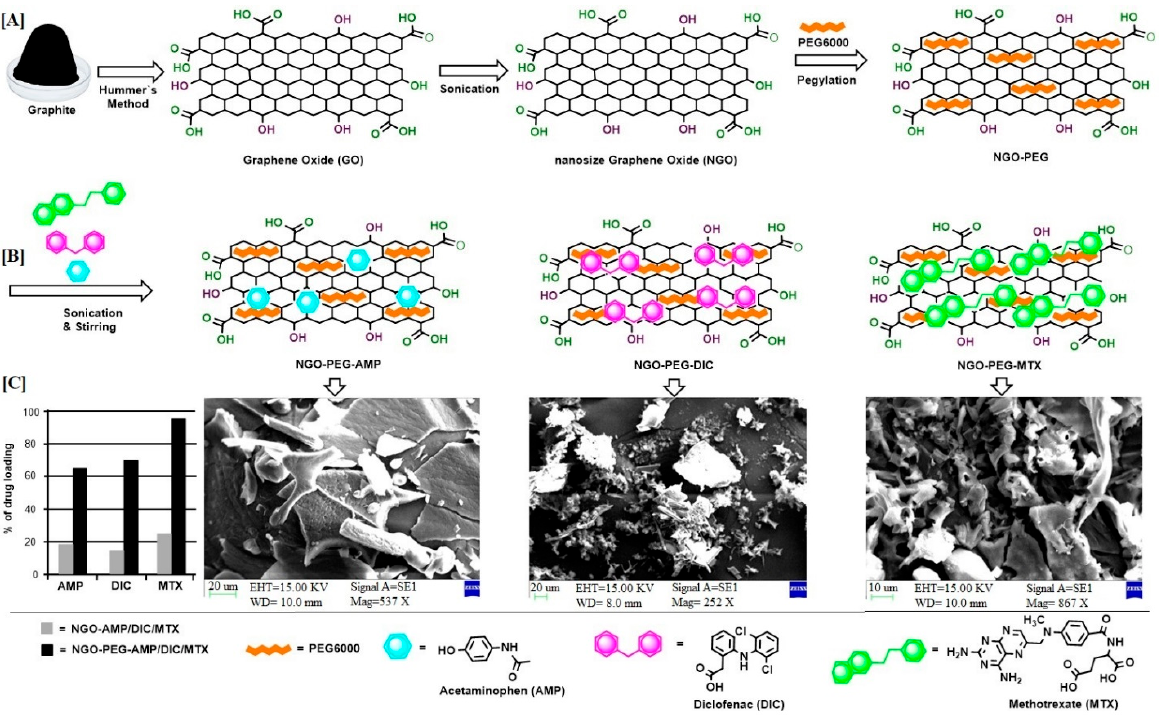
Figure 3. Schematic illustration showing the impact of the molecular structure of the drugs on the drug loading efficiency of NGO-PEG particles: ( A ) preparation of NGO-PEG, ( B ) loading of drugs onto NGO-PEG with different numbers of aromatic rings, ( C ) bar diagram showing the percentage of drug loading and SEM micrographs of drug-loaded NGO-PEG particles.